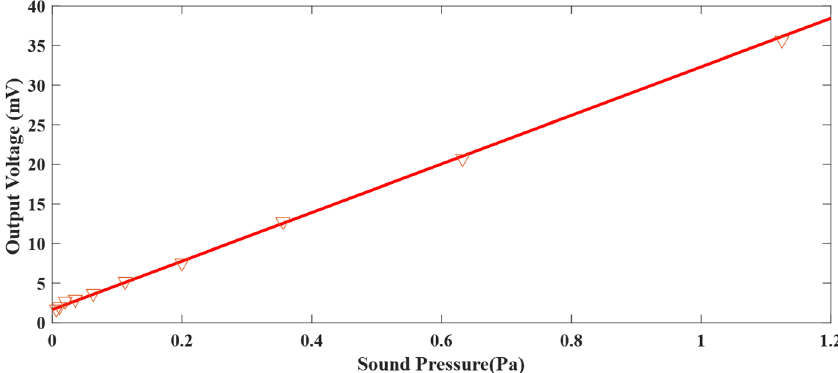
Figure 11. The test curve of sound pressure and output voltage.